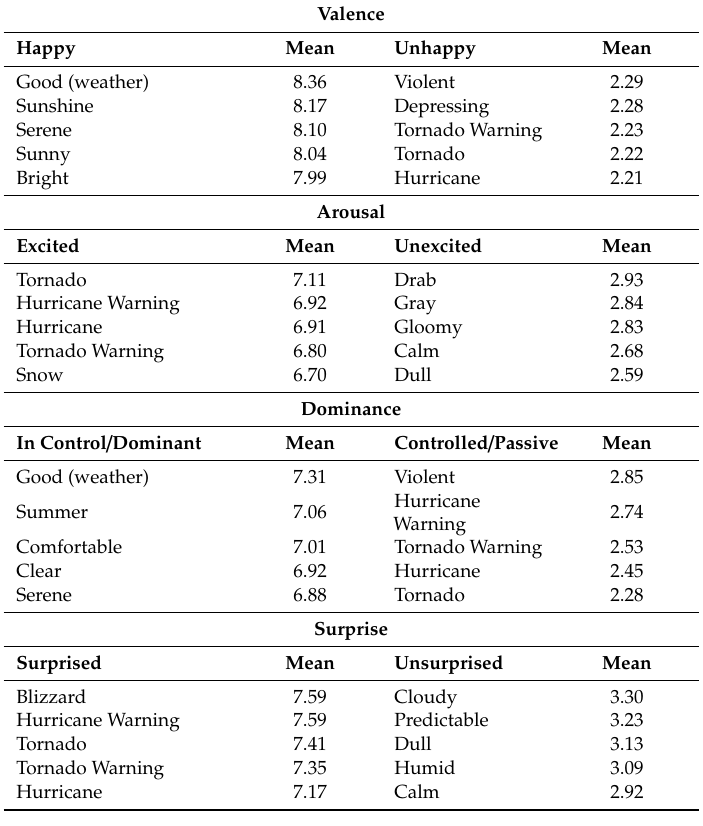
Table 2. Weather words with extreme ratings at each pole of valence, arousal, dominance, and